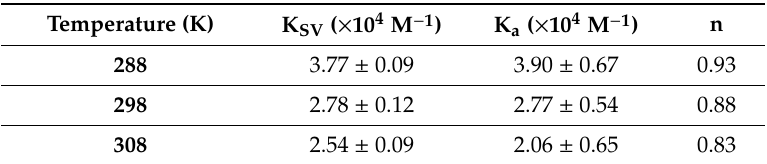
Table 1. Values of the Stern–Volmer constant (K SV ) for tryptophan fluorescence quenching of RSA, binding constants (K a ), and the number of binding sites (n) for the interaction between RSA and piperine at 288 K, 298 K, and 308 K.